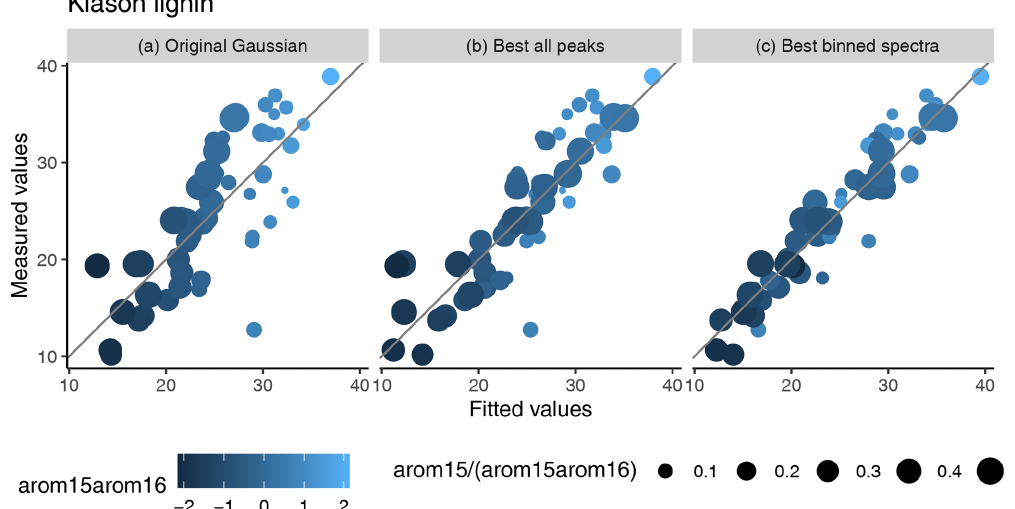
Figure 6. Measured training data Klason lignin contents versus fitted values [mass-%] of the original model (a) , the improved model using extracted peaks (b) , and the improved model using binned spectra (c) . Points are scaled according to the relative contribution of the arom15 peak to arom15arom16 . The color gradient represents arom15arom16 values. The diagonal line represents values where measured and fitted values are